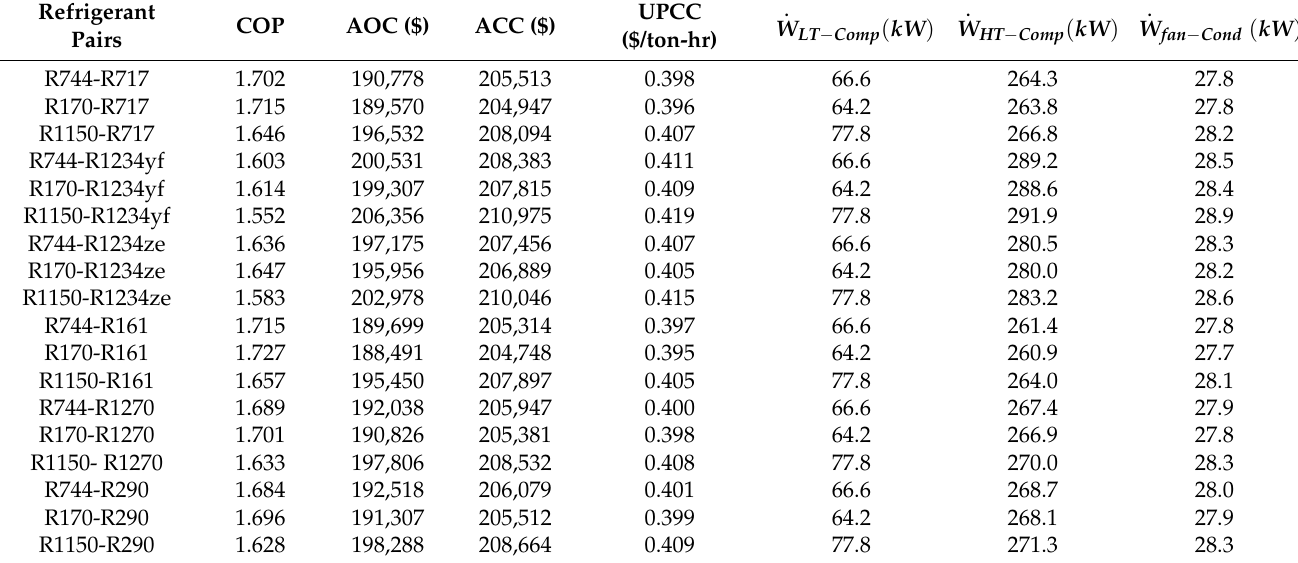
Table 6. Thermodynamic and economic results obtained for different refrigerant